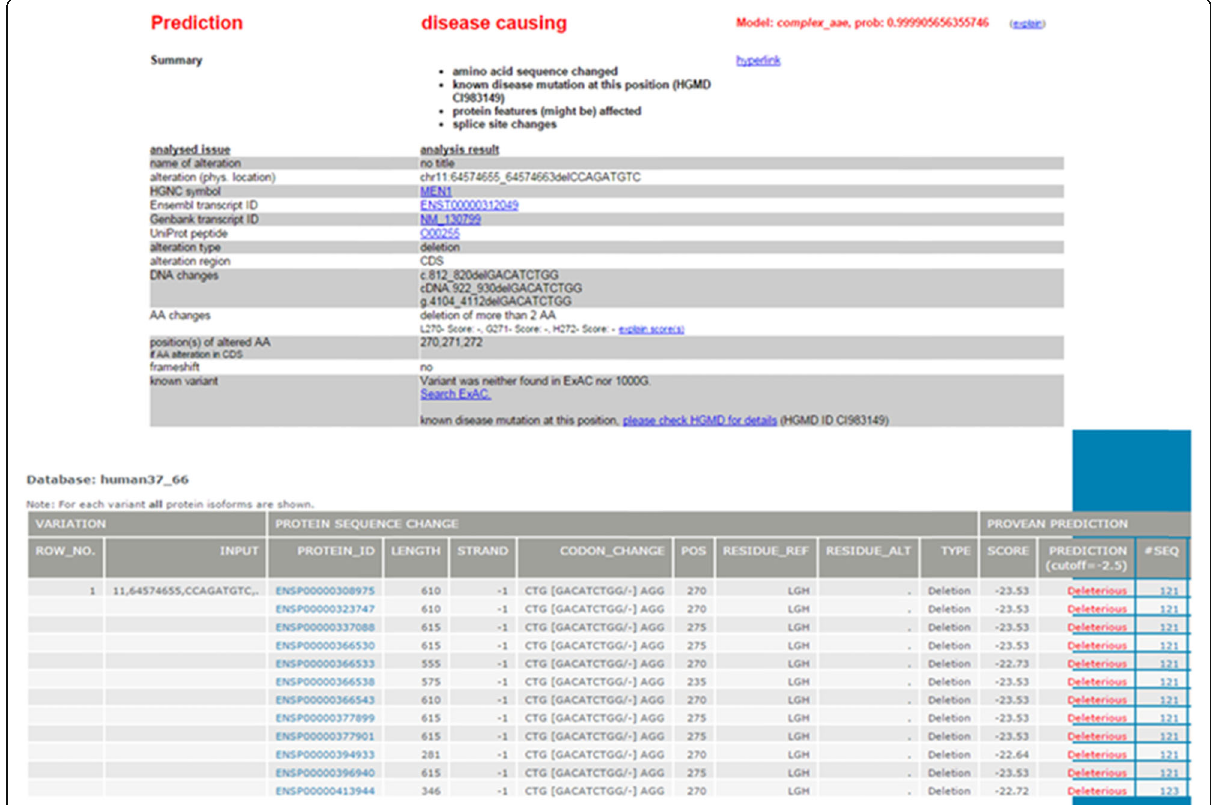
Fig. 2 Analysis of the MEN1 gene revealed a new mutation in exon 5 (variant c.812_820del, p.Gly271_Leu273del). The prediction of the new variant pathogenicity was performed with Mutation Taster (http://www.mutationtaster.org) and PROVEAN (http://provean.jcvi.org/index.php) software and revealed deleterious